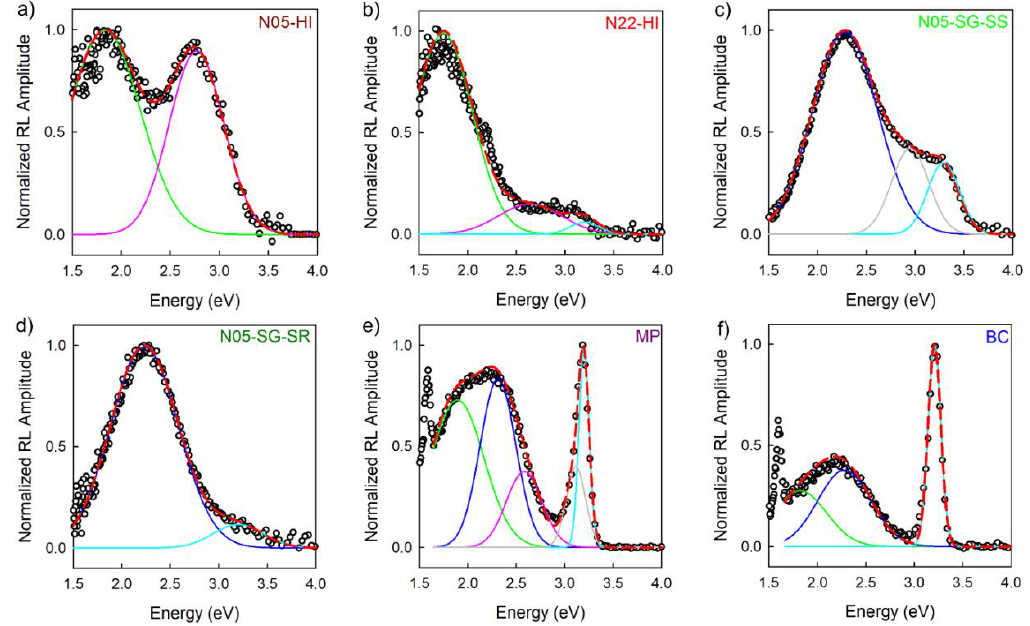
Figure 4. Gaussian deconvolution of normalized RL spectra of different ZnO materials at 300 K and 10 − 7 mbar ( a – f ): Gaussian components (green, blue, pink, light blue, and grey solid lines) obtained by numerical fit are shown together with experimental curves (black empty circle lines). The curve representing the whole numerical fit (red dashed line) is superimposed to the experimental data. The sets of all parameters of the deconvolution are listed in Table S2.